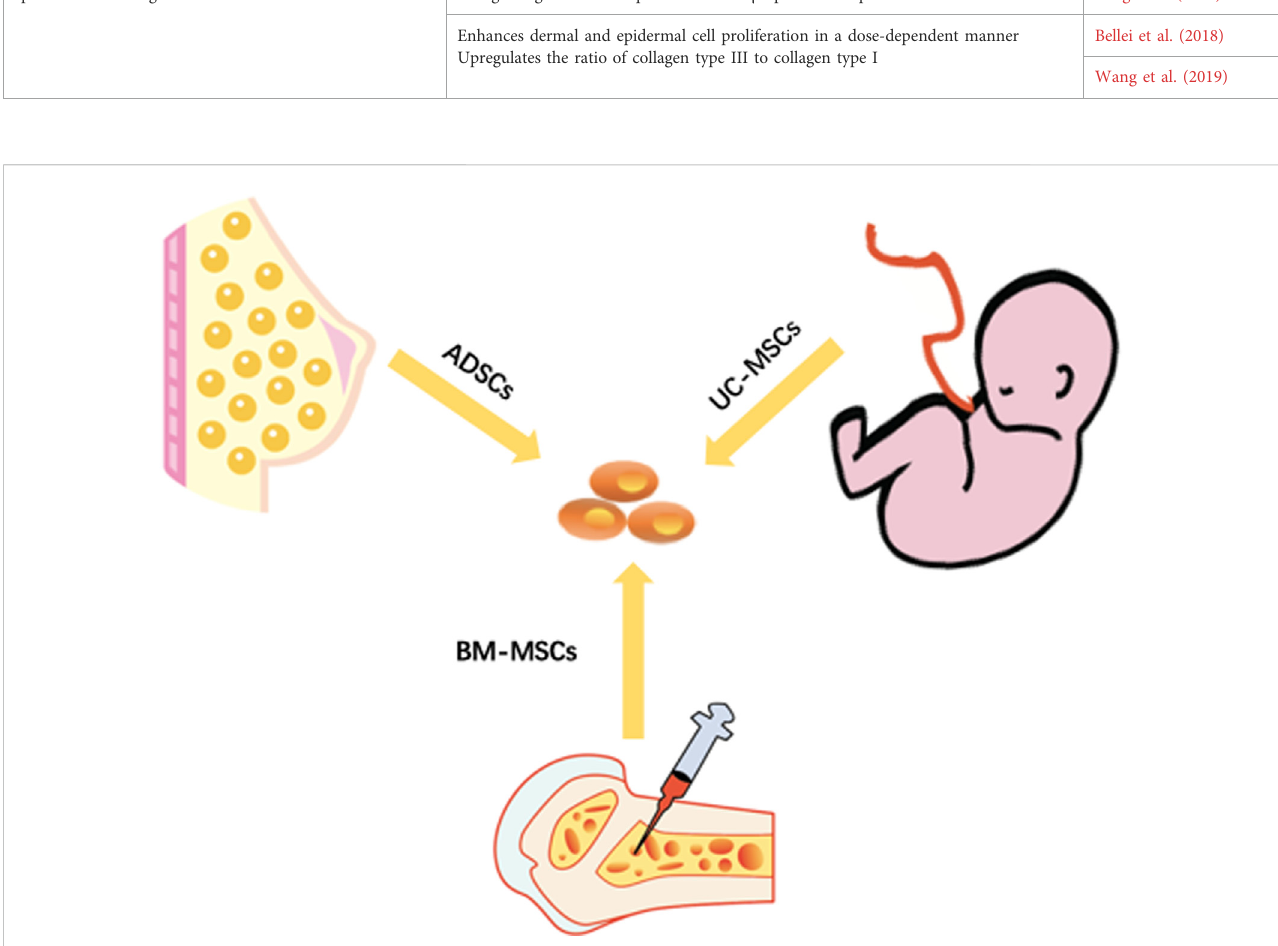
FIGURE 2 Three main sources of stem cells. ADSCs are adipose-derived stem cells. UC-MSCs are umbilical cord mesenchymal stem cells. BM-MSCs are bone marrow mesenchymal stem